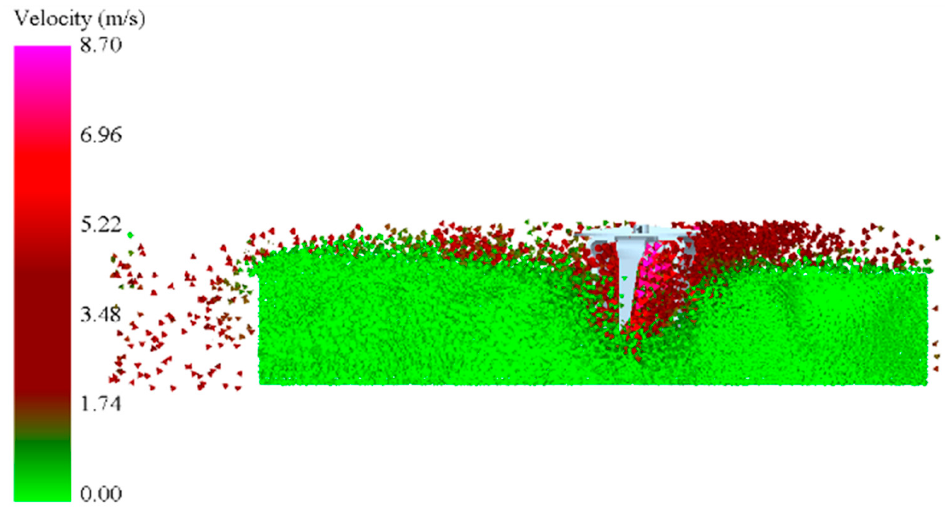
Figure 9. Local enlargement of simulation test.